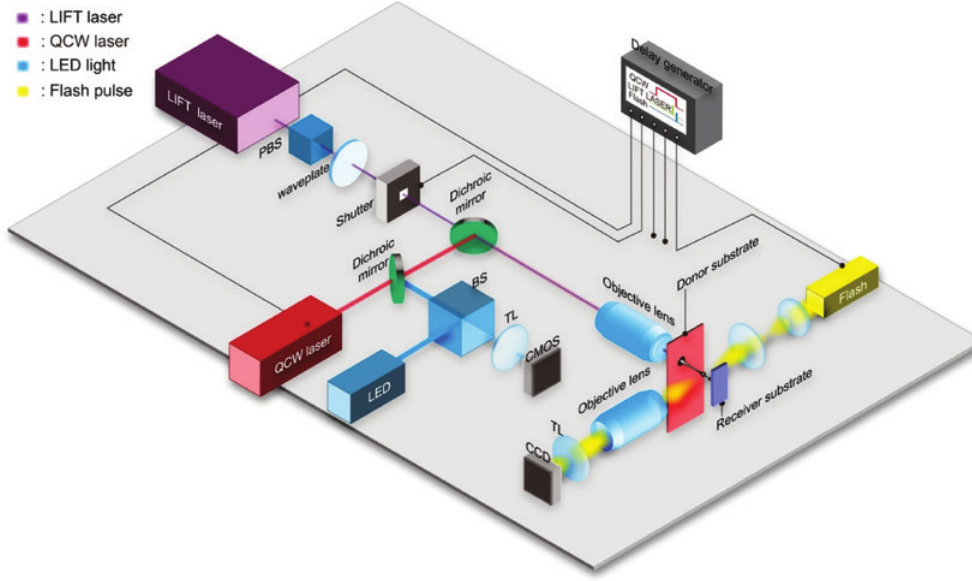
Figure 6: Experimental setup of the double-pulse LIFT. The QCW laser provides long pulse irradiation to melt the film. The LIFT laser (fs or ps) induces the ejection process in the liquid phase. The flash lamp and the CCD camera are used to acquire the time-resolved shadowgraphy images.